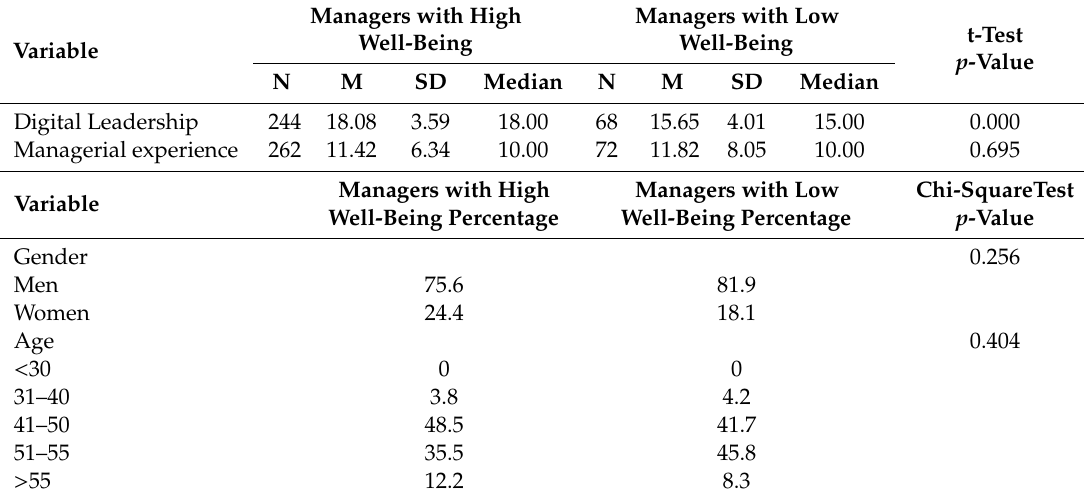
Table 4. Descriptive statistics of the independent variables for managers with high and low psychological